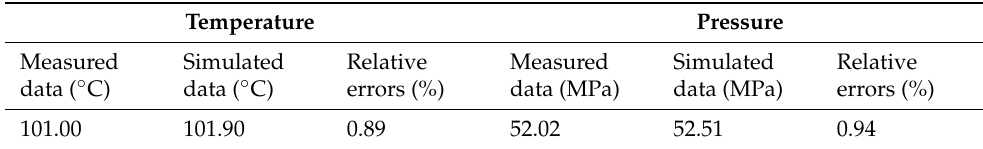
Table 1. The measured and simulated data of Cao-8 in the first test.